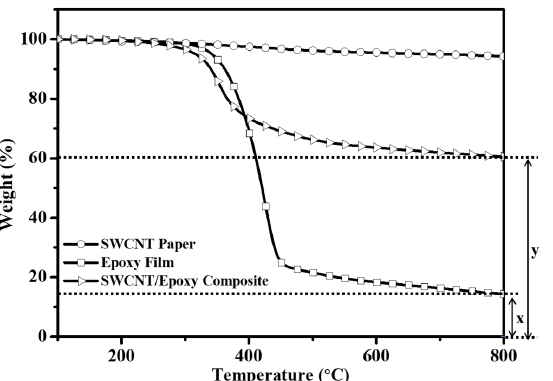
Figure 4. TGA plots of epoxy film, SWCNT paper, and SWCNT/epoxy composite; ‘x’ and ‘y’ are what remains after epoxy film and SWCNT/epoxy composite were burned, respectively.